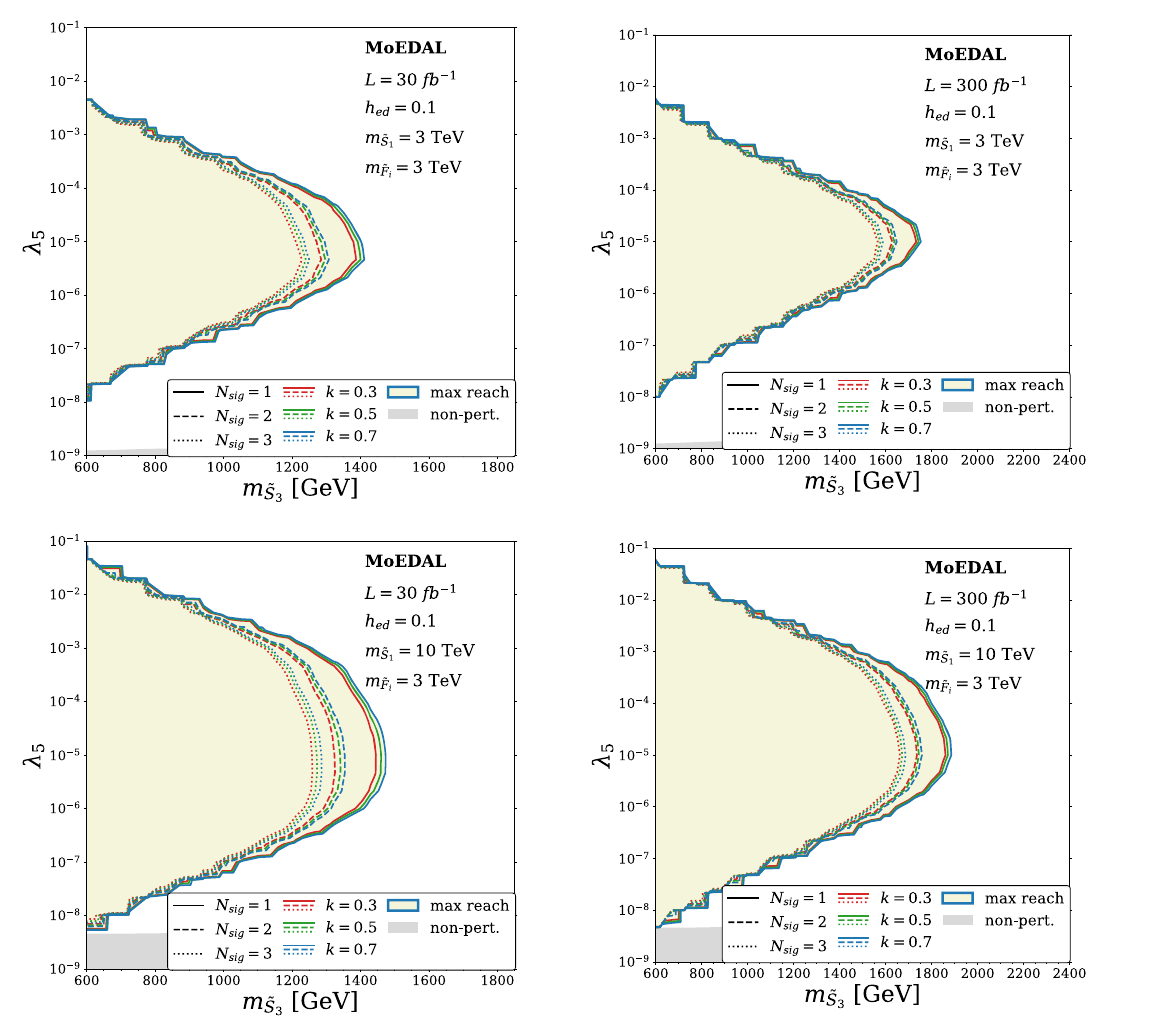
= 3 TeV ( i = 1 , 2 , 3) F i F (cid:14) (cid:15) | ( h ) | , | ( h ¯ ) | ≥ F ij ij F